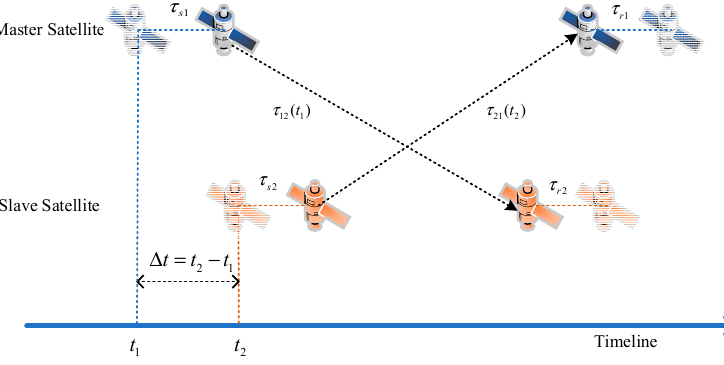
Table 1. Detail structure of inter-satellite transmission subframe.